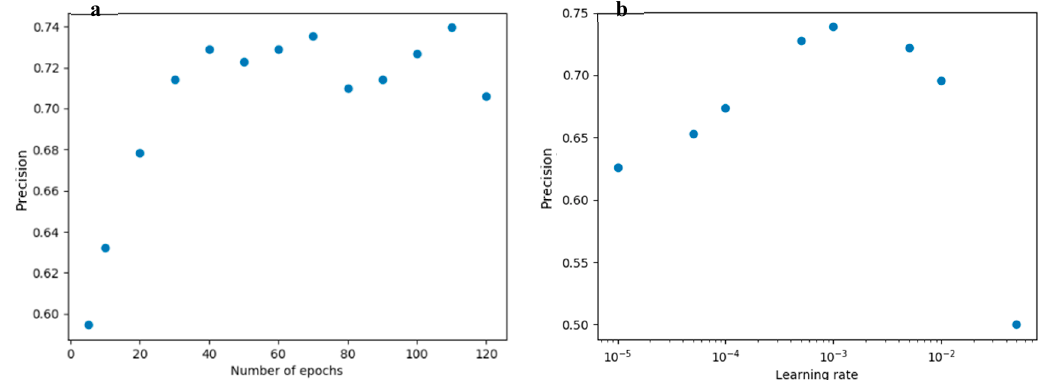
Figure 5. Variability in the precision of the model using different configurations. ( a ) When the trained model is applied on the test dataset, one can see that there is no significant improvement in the precision after ~30 to 40 epochs. ( b ) The same is done while varying the learning rate values. The best results are obtained between 10 − 4 and 1.2 − 3 .